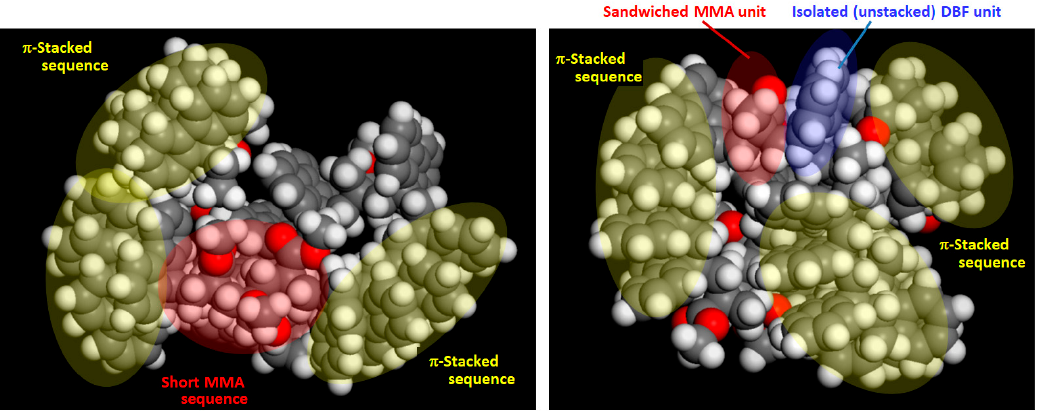
Figure 6. Poly(DBF- co -MMA) structure obtained through MD simulations for ca. 20 ns at 300 K: views from two angles.